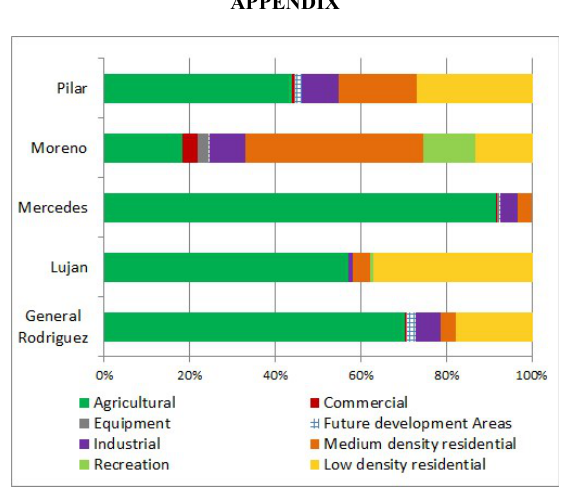
Figure 7. The urban zoning in the study area (Ley 8912/77,